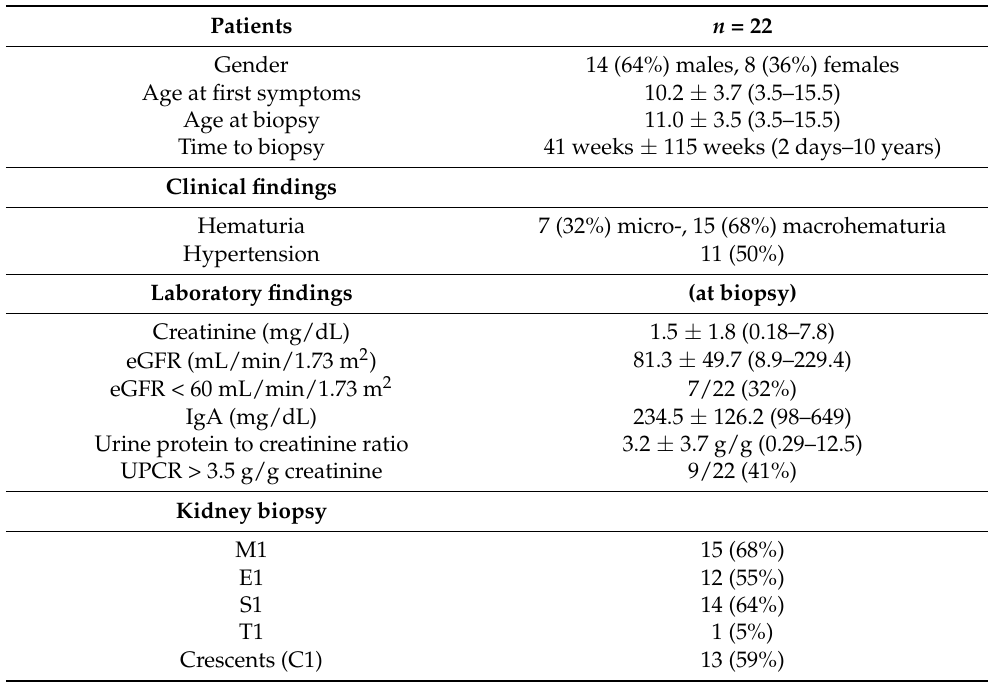
Table 1. Symptom onset and renal biopsy.